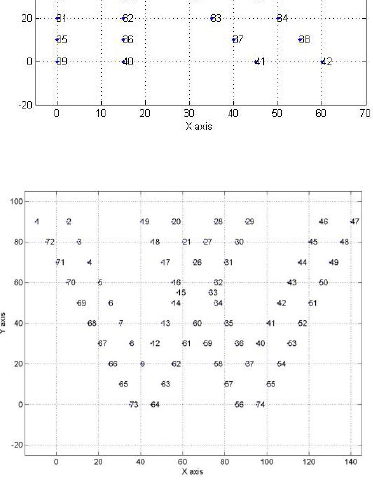
Figure 16. The four letters